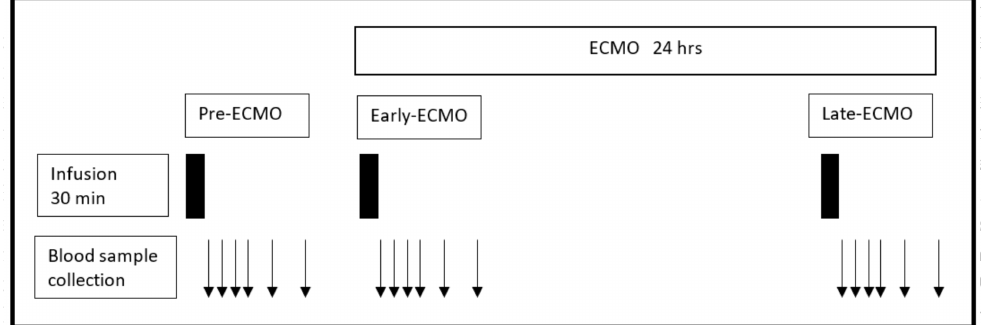
Figure 1. Schematic representation of the time points where blood sampling was performed. ECMO = Extracorporeal membrane